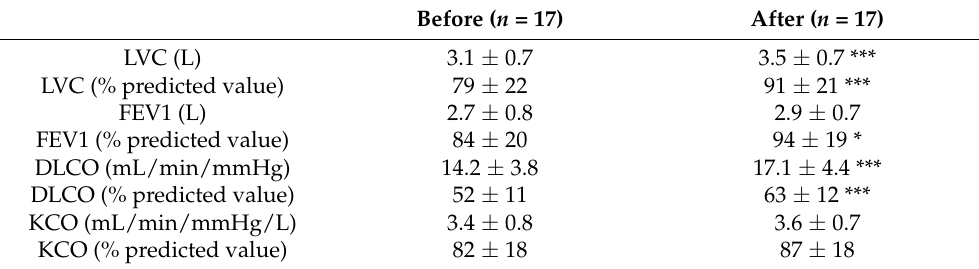
Table 2. Before rehabilitation and post-rehabilitation spirometry of COVID-19 patients.